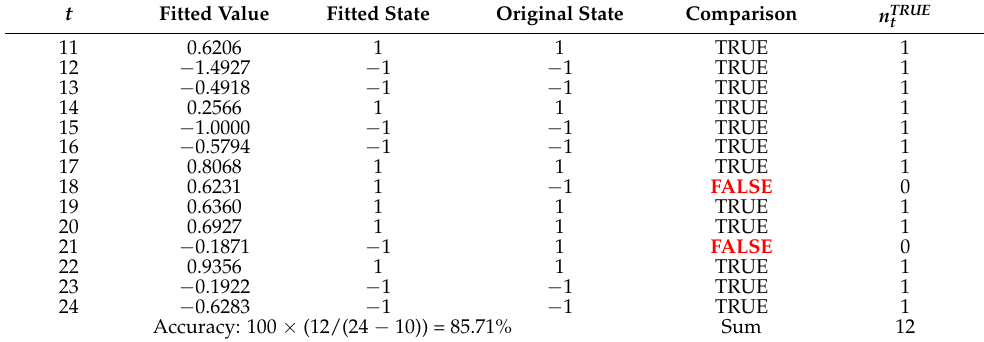
Table 4. Fitted series with corresponding states and model accuracy.